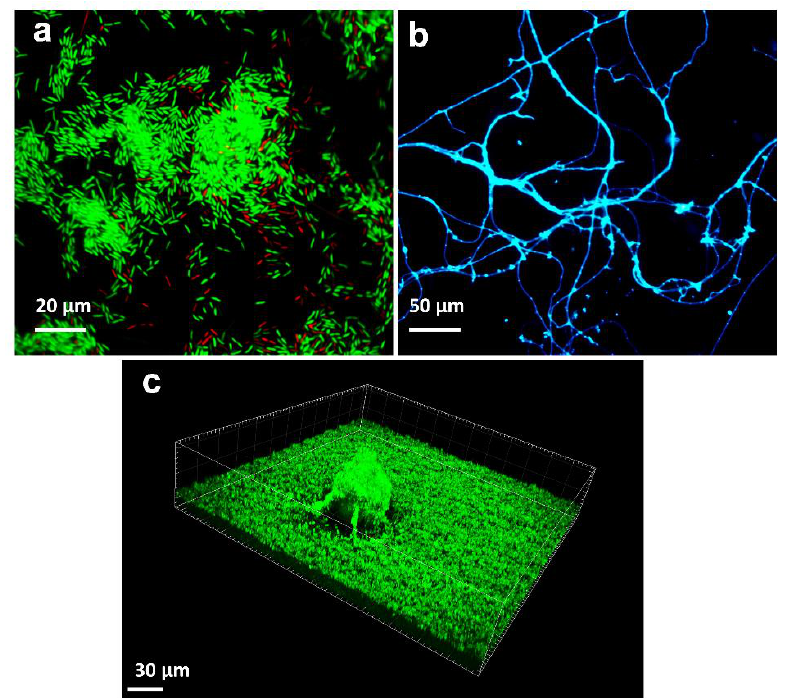
Figure 4. Epifluorescence microscope images of ( a ) E. coli biofilm grown on low density polyethylene surface and stained with Live / Dead BacLight; ( b ) Aspergillus niger biofilm grown on fluorinated coated glass surface and stained with the Fluorescent Brightener 28 dye; and ( c ) confocal laser scanning microscopy (CLSM) image of green fluorescent protein (GFP) P. aeruginosa biofilm grown on polycarbonate surface.